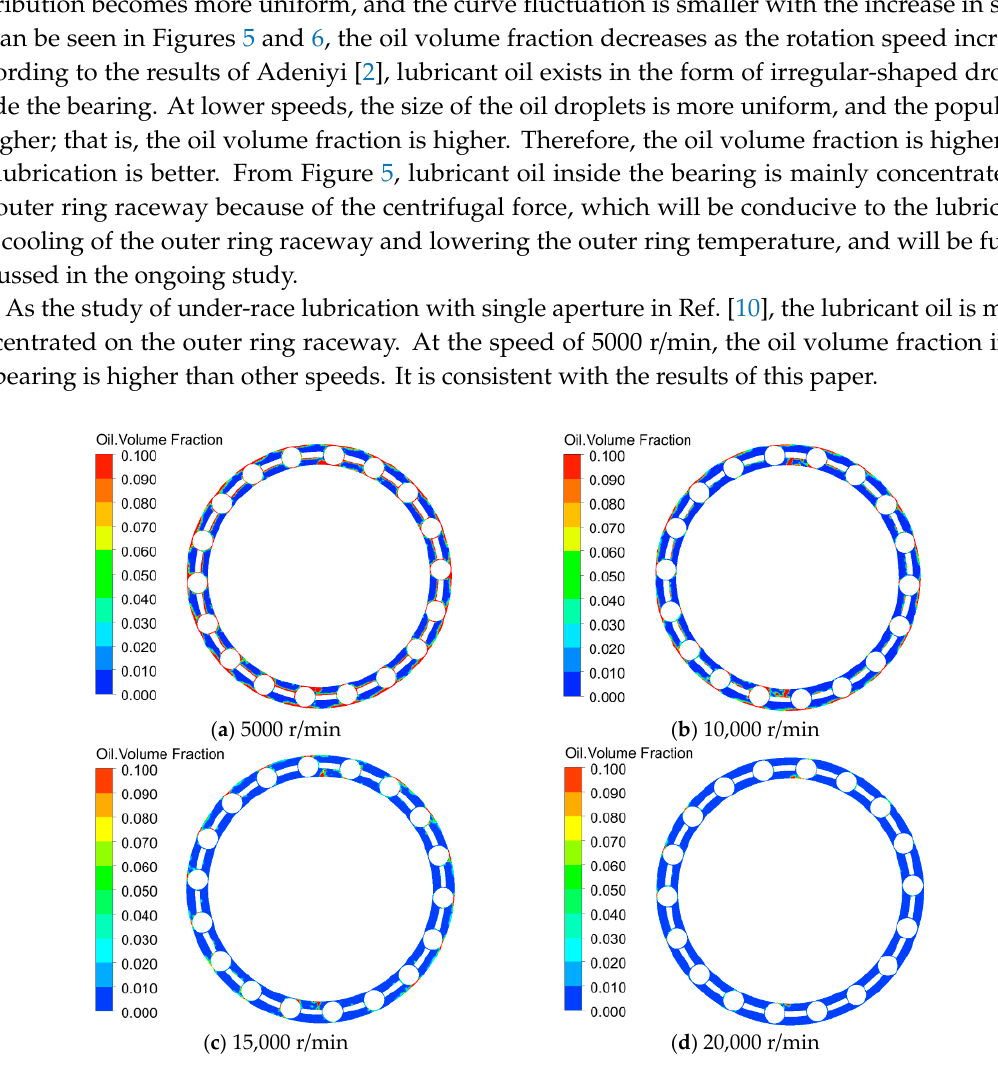
Figure 5. Oil distribution in the Y = 0 cross-section with different rotational speeds. Processes 2020 , 8 , x FOR PEER REVIEW